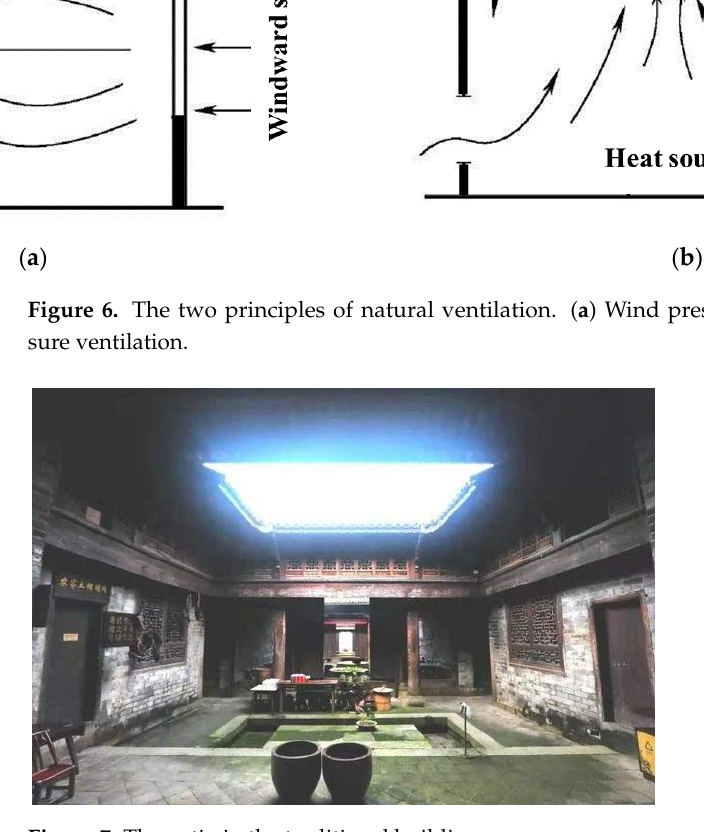
Figure 7. The patio in the traditional building.